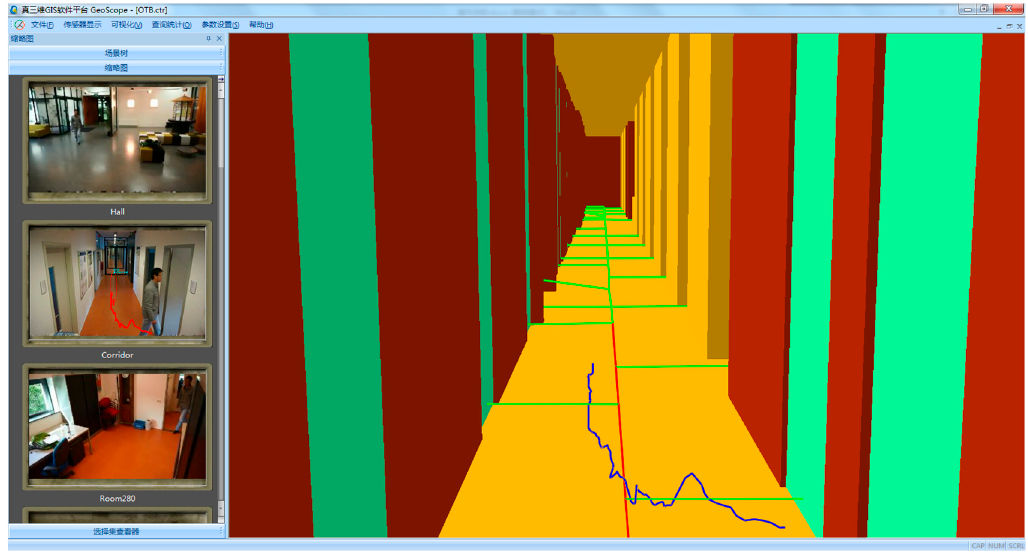
Figure 7. The visualization of GeoVideo movement object (MVO) on Video GIS platform.